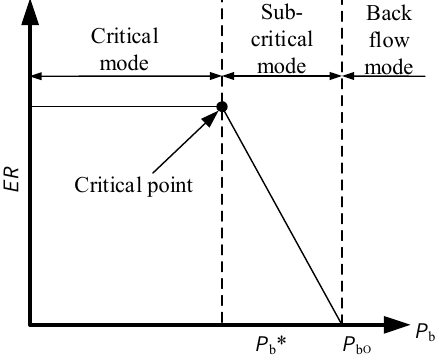
Figure 3. Typical performance curve of a supersonic ejector.